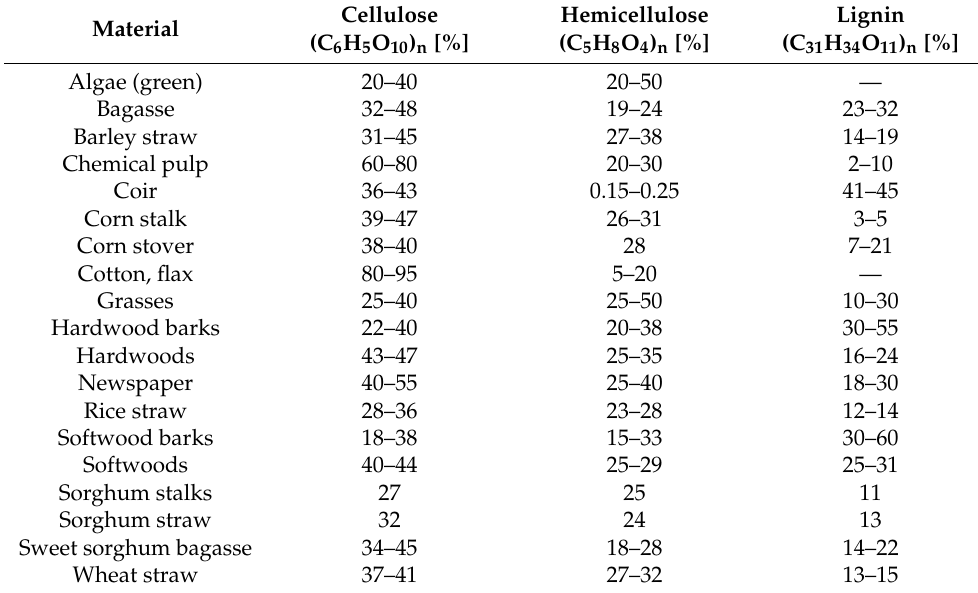
Table 1. Composition of various agricultural and other lignocellulosic residues